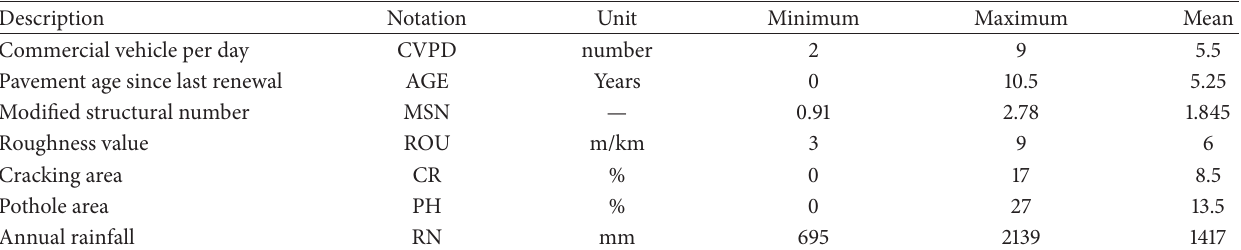
Table 2: Range of data used for model development and